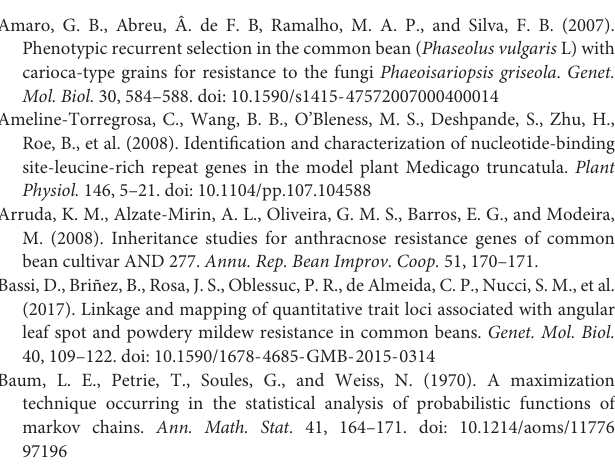
Supplementary Figure 1 | Linkage map estimated by 1,091 SNPs obtained by GBS and another 23 molecular markers using the AM population composed of 91 BC 2 F 3 lines originating from the inter-gene pool cross (AND 277 × IAC-Milênio). Supplementary Table 1 | Details of the 125 carioca cultivars that make up the CDP: name, grain size (mm), commercial classification, institution of origin, adjusted mean (BLUE), normalized data of evaluation of resistance to angular leaf spot at different plant growth stages (V2, V3, and R8 stages), genealogy, and genotypic matrix. Supplementary Table 2 | Phenotypic and genotypic matrices of the AM segregating population composed of 91 BC 2 F 3 lines: marker name, position (cM and pb), and alleles for 1,091 SNPs and another 23 molecular markers used in the AM linkage map. Supplementary Table 3 | Genetic annotation of each locus mapped for the three evaluations of resistance to angular leaf spot (V2, V3, and R8) through both approaches: GWAS and linkage mapping. First table is composed only of genes with genetic annotations related to disease resistance identified in the